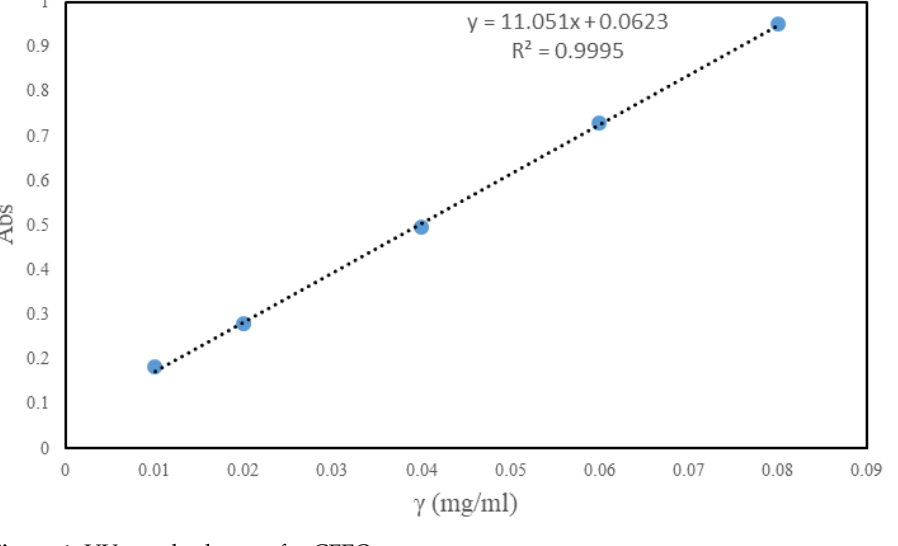
Figure 1. UV standard curve for CFEO.